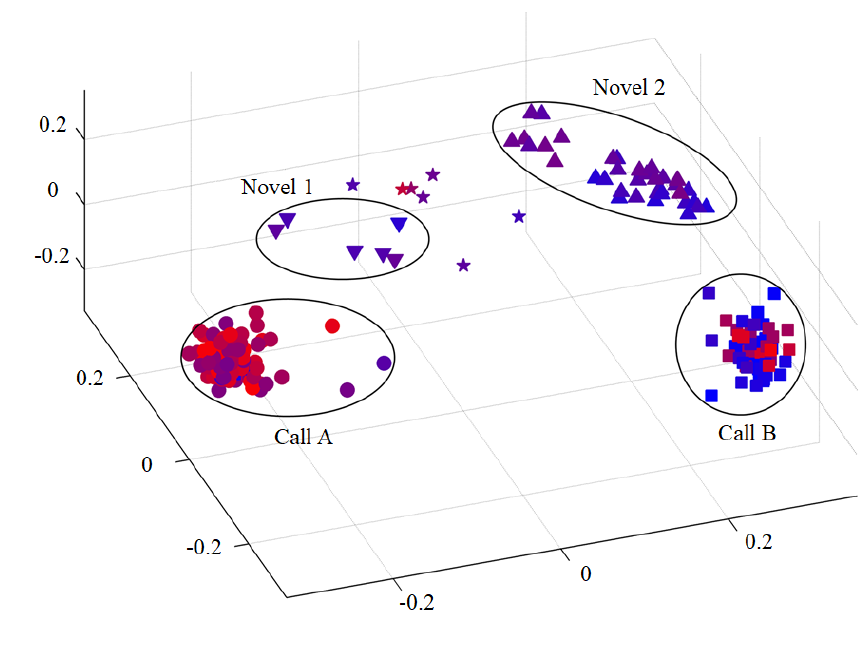
Figure 2 . A multidimensional scaling (MDS) space built from similarity of sound spectrograms acquired in a session of Experiment 3 (corresponding to the dotted line of Figure 1). The bird created several vocal patterns in addition to call A and B, when the bird was struggling. The marker represents different pattern of the spectrogram categorized by visual inspection (circle; call-A, square; call-B, downward-triangle; novel call-1, upward-triangle; novel call-2, star; others). The plot color indicates progress of the trials; purely red means the first trial and purely blue means the last